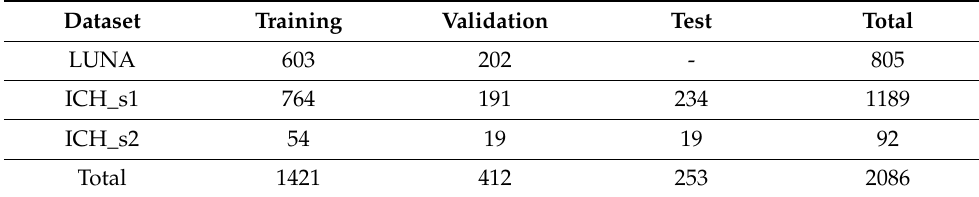
Table 2. CT series datasets used for the CADs’ development.